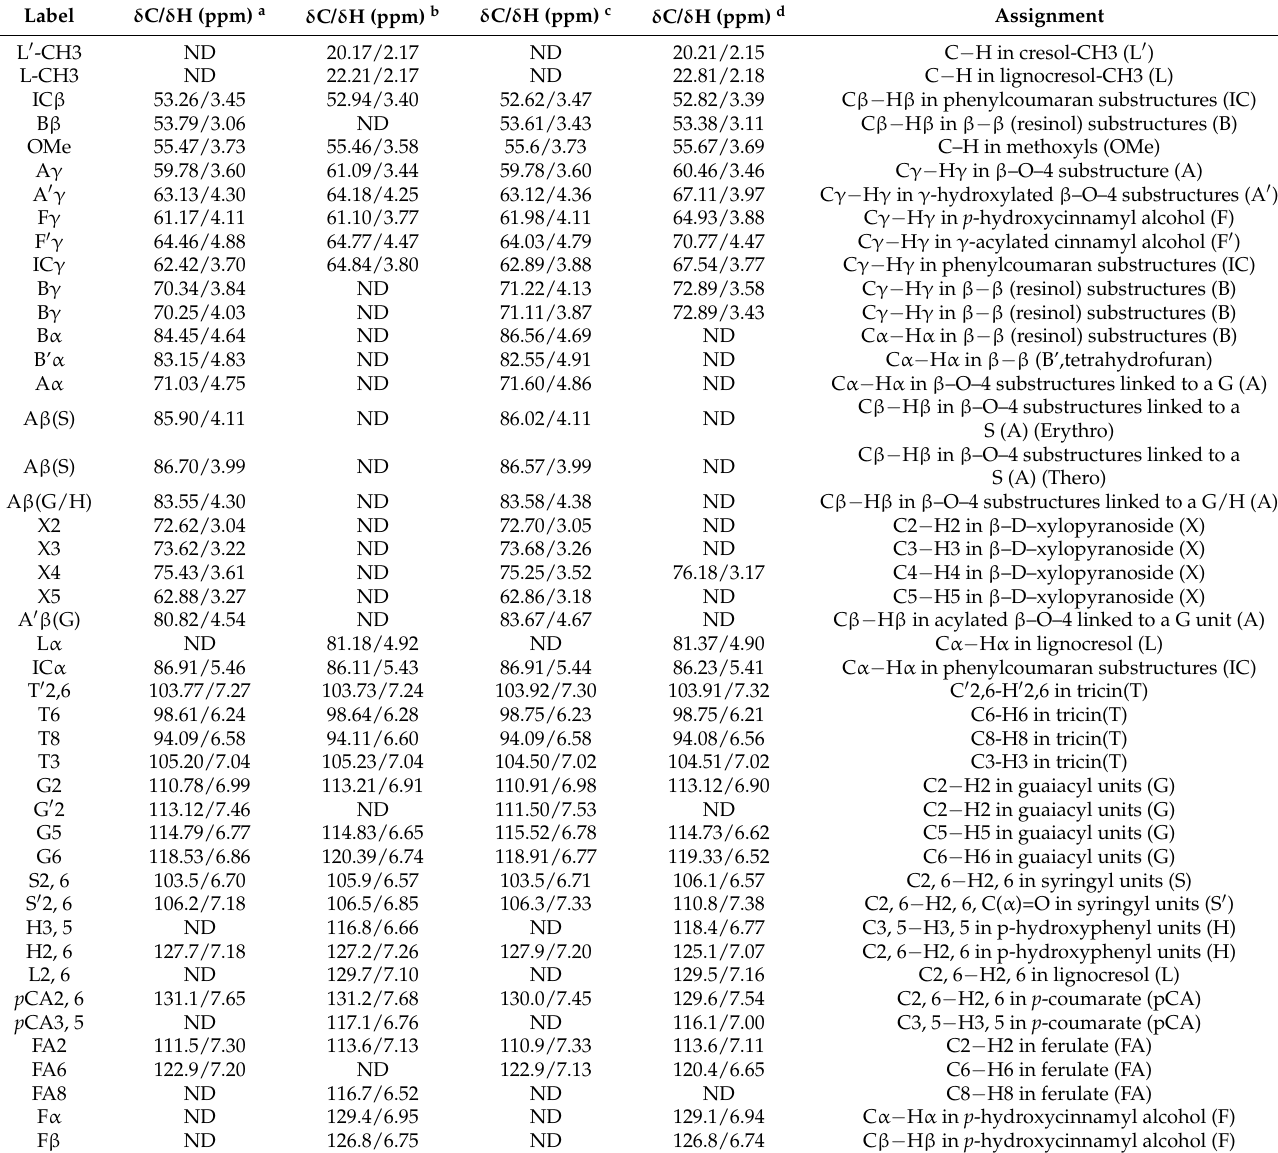
Table 8. The units and linkages proportion of MWL and